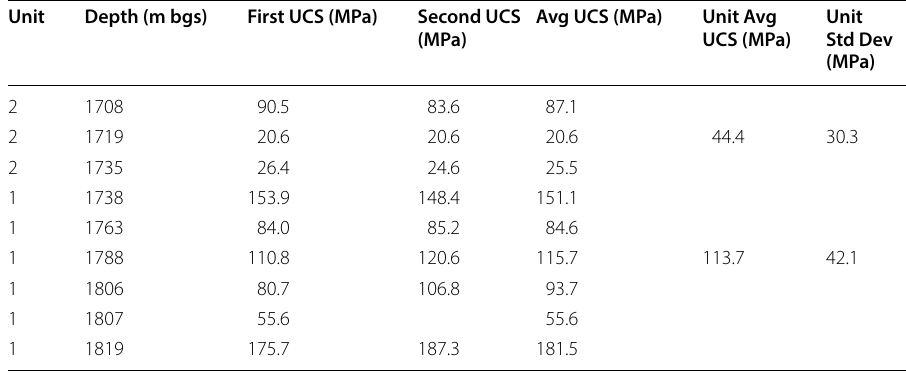
Table 4 Results of unconfined uniaxial compressive stress experiments